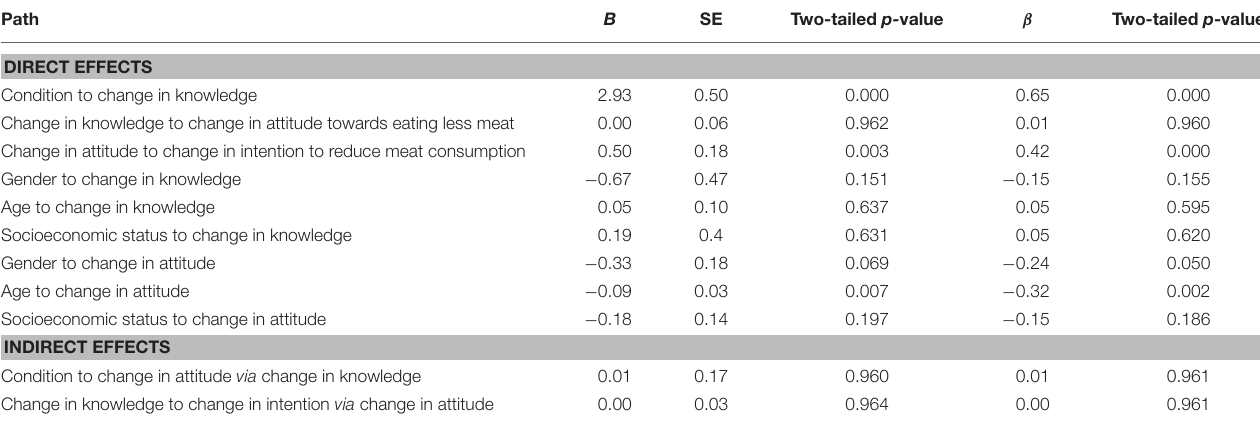
TABLE 1 | Unstandardized and standardized parameter estimates of the path model. Path